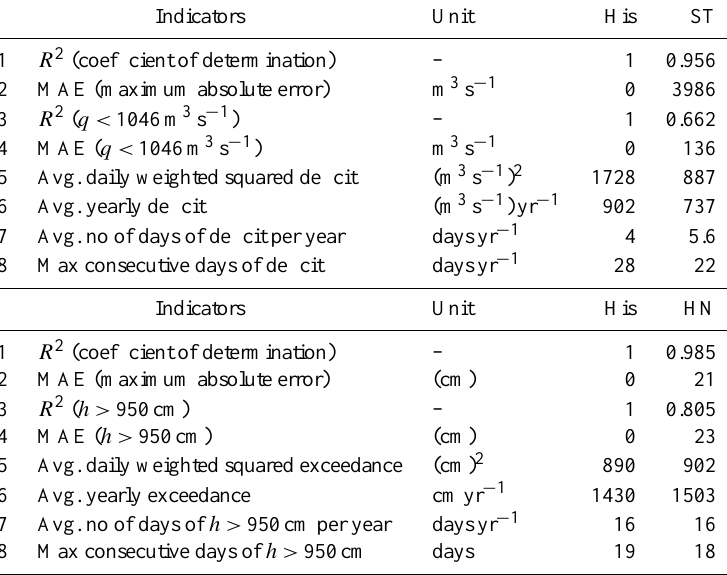
Table 1. Performance indicators of the downstream models (His: historical data; ST: SonTay model; HN: Hanoi model) over the period